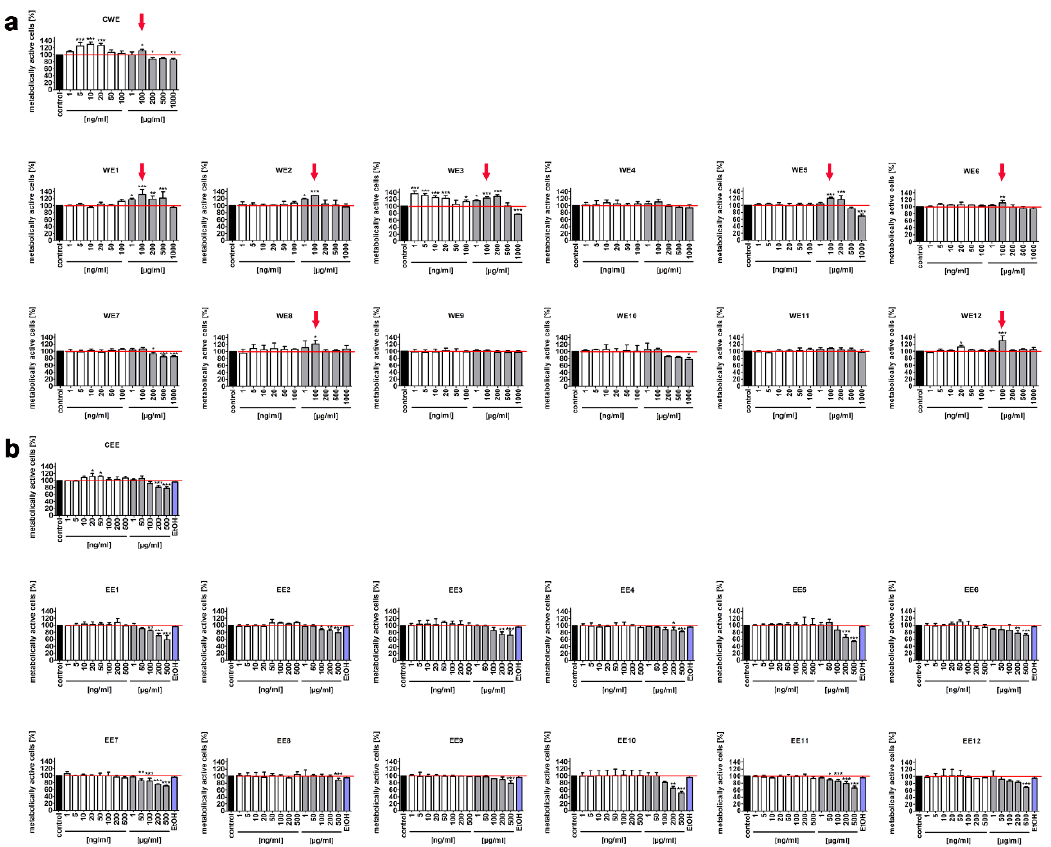
Figure 1. Extract-mediated changes in metabolic activity (MTT assay) of normal human fibroblasts (BJ). Metabolic activity at standard growth conditions (control, a black bar) is considered as 100%. ( a ) The e ff ects of water extracts (WE, twelve modified clones from WE1 to WE12) are shown. Control clone water extract is denoted as CWE. ( b ) The e ff ects of ethanolic extracts (EE, twelve modified clones from EE1 to EE12) are shown. Control clone ethanolic extract is denoted as CEE. To emphasize extract action, a red horizontal line is added. The e ff ect of 80% ethanol (a solvent of ethanolic extracts, a violet bar) is also shown. White bars indicate the extract concentrations in ng / mL, whereas grey bars indicate the extract concentrations in µ g / mL. Red arrows indicate the concentration of water extract (100 µ g / mL) that was selected for further analysis based on the stimulatory e ff ect on the metabolic activity of the majority of modified clone water extracts used. Bars indicate SD, n = 5, *** p < 0.001, ** p < 0.01, * p < 0.05 compared to the control (ANOVA and Dunnett’s a posteriori test).